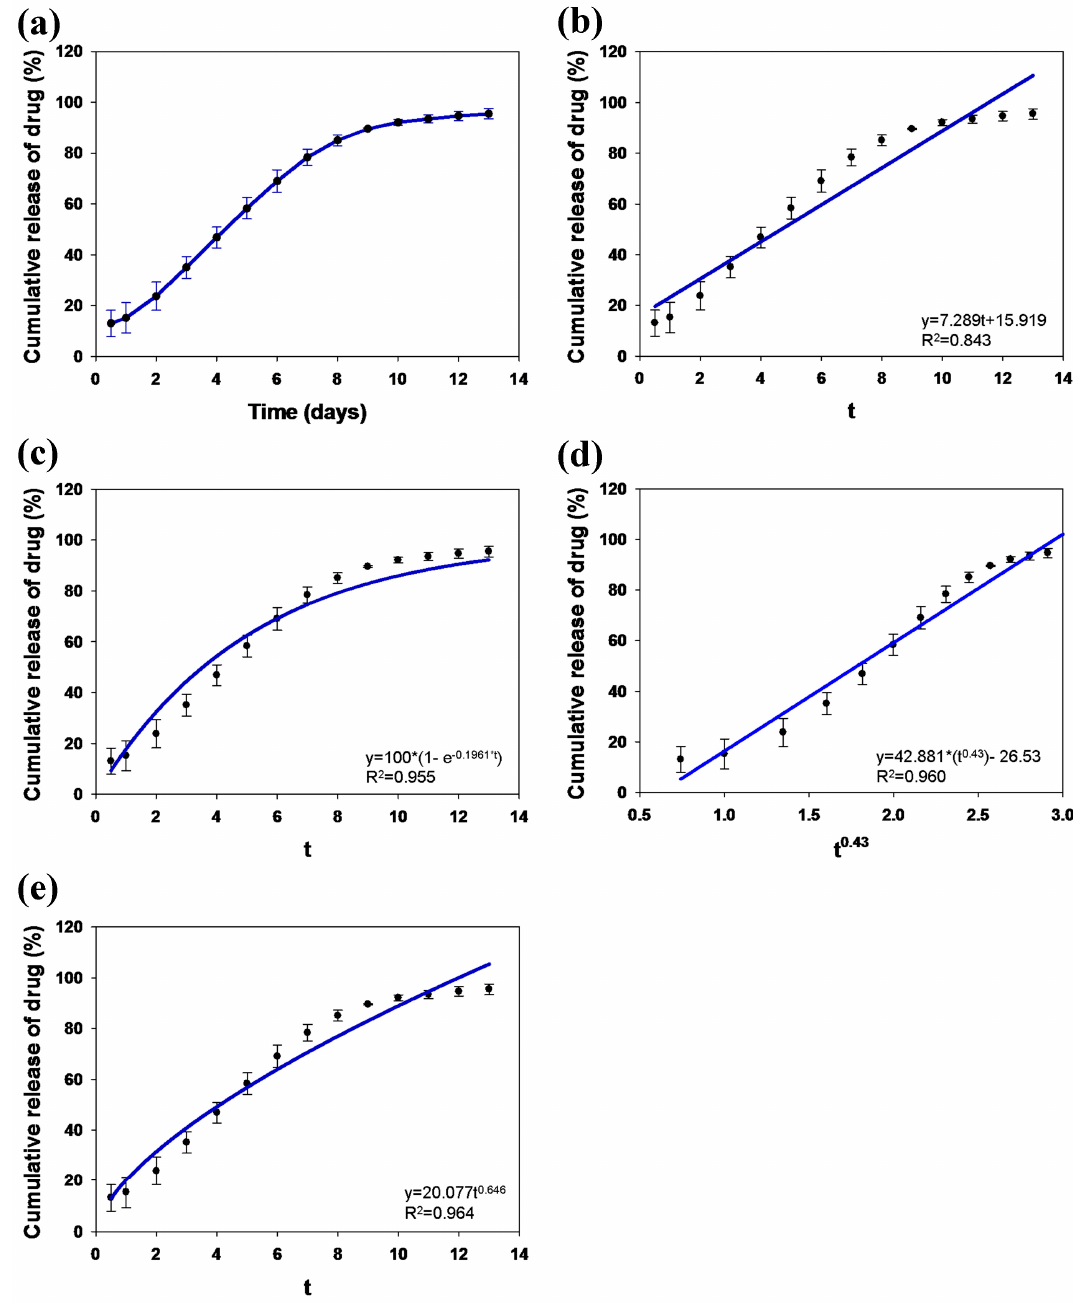
Figure 7. ( a ) In vitro cumulative tetracycline (TC) release from TC-loaded MFB. Curve was fitted with an equation of ( b ) zero-order; ( c ) first-order; ( d ) Fickian matrix diffusion; ( e ) Ritger-Peppas models.